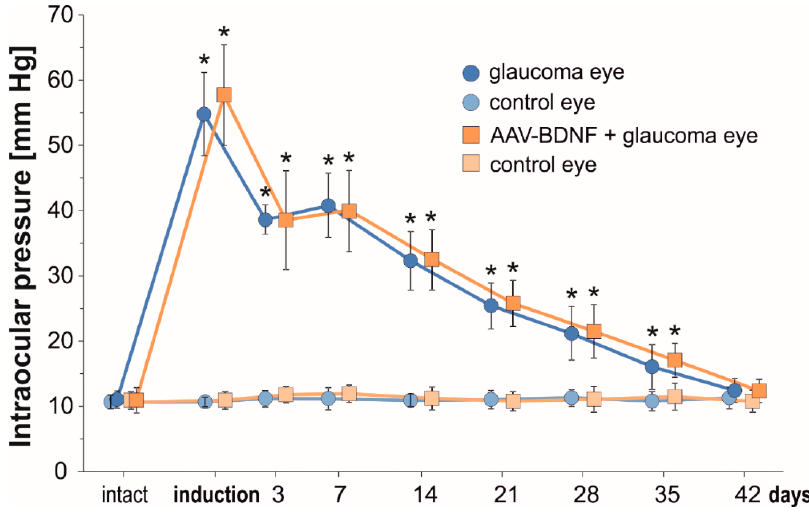
Figure 1. The temporal course of intraocular pressure (IOP) from the first till 42 days after uniocular (Right eye) microbead injection. In the Right eye there is a significant increase in the IOP immediately after glaucoma induction. In the Left untreated eye, IOP remains unchanged and is maintained within a range of pre-injection values. AAV2-BDNF administration to the Right eye preceded glaucoma induction by 3 weeks. Data are expressed as mean ± SD from 8 (glaucoma group) and 7 (AAV2-BDNF+ glaucoma group) rats. * p < 0.01, different from intact and between time-points (except for day 3 vs. 7). For the comparison of IOP levels in time, a t -test for dependent variables was used.